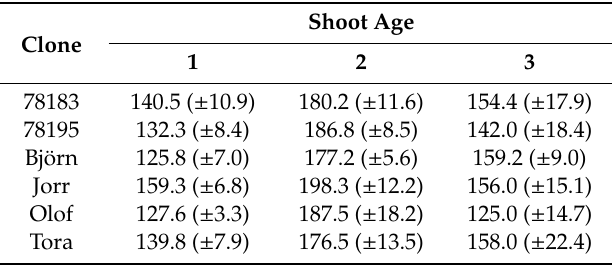
Table 1. Biomethanation potentials (NmL (g VS) − 1 ; standard deviation in parentheses) of the Salix clones at di ff erent harvest